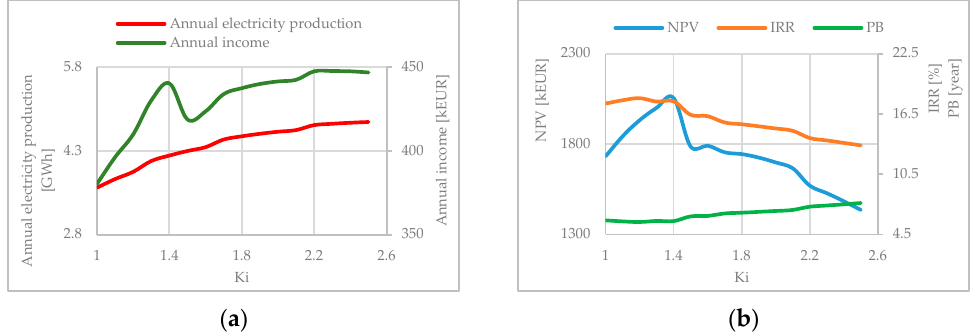
Figure 8. ( a ) Annual electricity production and income—Stožernica SHPP; ( b ) NPV, IRR, and PB— Stožernica SHPP.